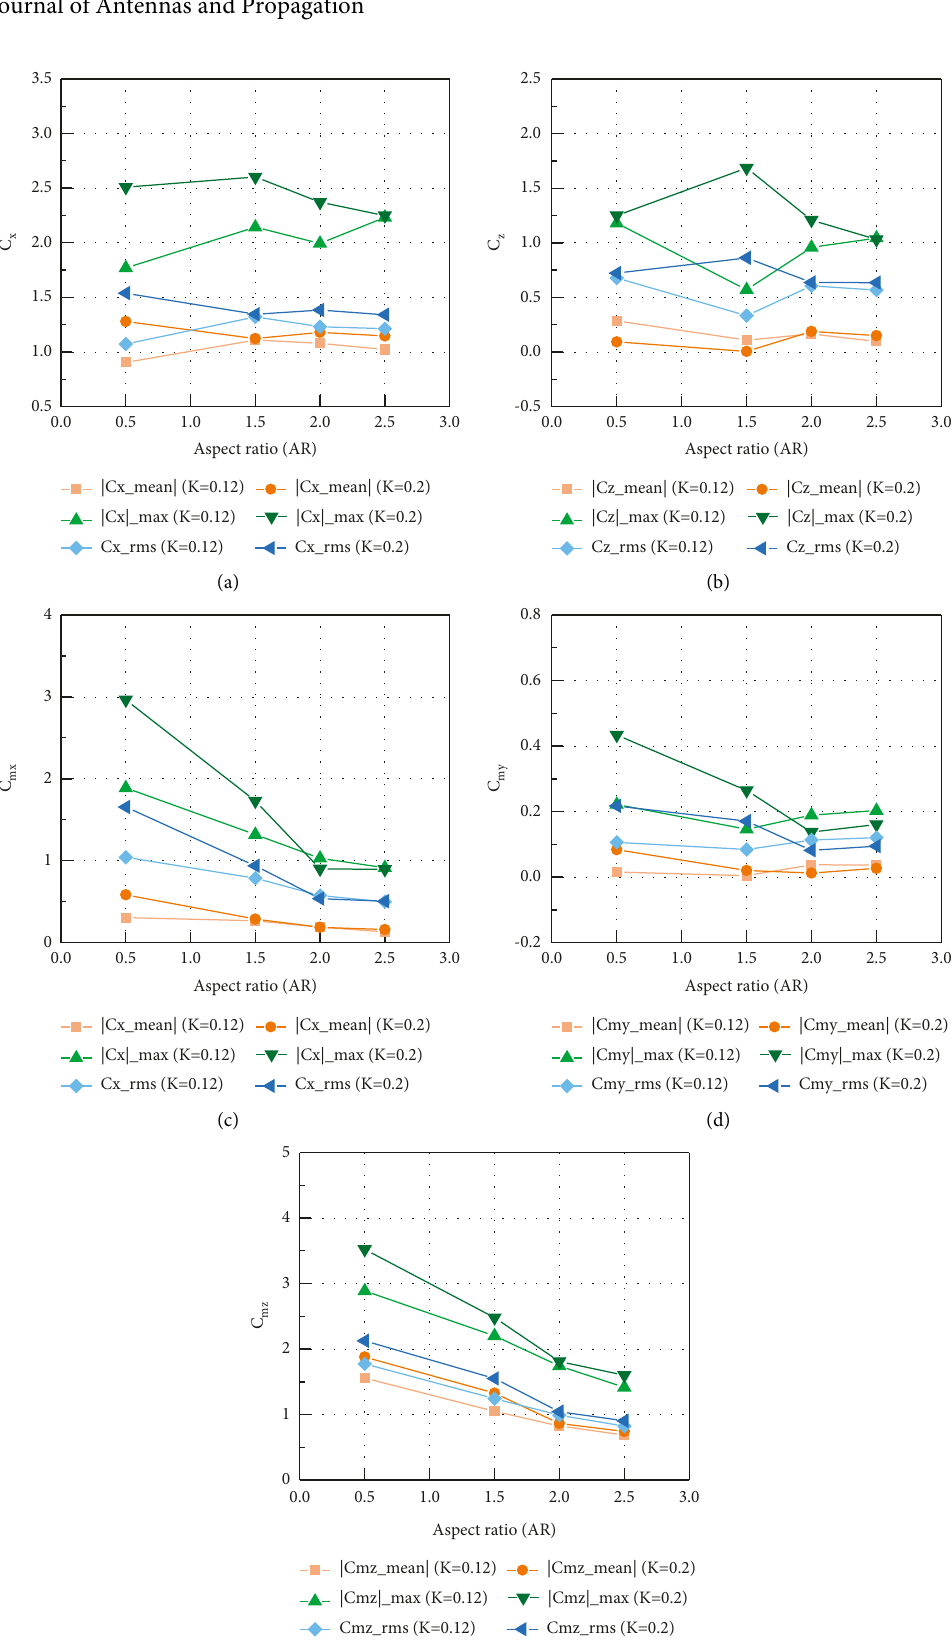
Figure 7: Mean, maximum, and root mean square values of the aerodynamic coefficients with respect to the aspect ratio when the antenna is rotating azimuthally at different reduced frequencies: (a) C x – β , (b) C z – β , (c) C mx – β , (d) C my – β , and (e) C mz – β ( K � 0.12 and K �